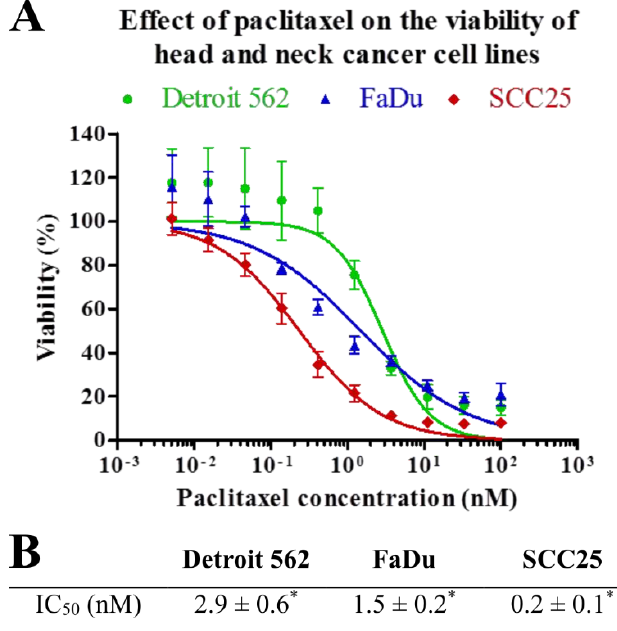
Figure 2. Effect of paclitaxel on cell viability. HNSCC cell lines were analyzed in parallel by MTT after 72 h of treatment with paclitaxel at different concentrations. ( A ) IC 50 curves of paclitaxel on